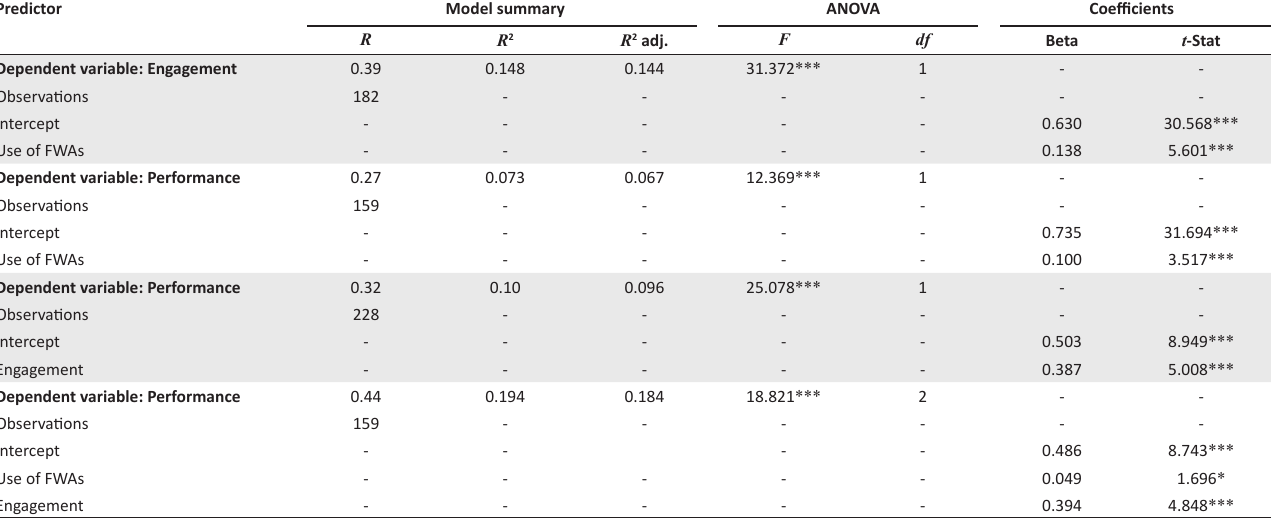
TABLE 5: Regression of flexible work arrangements use, engagement and performance.